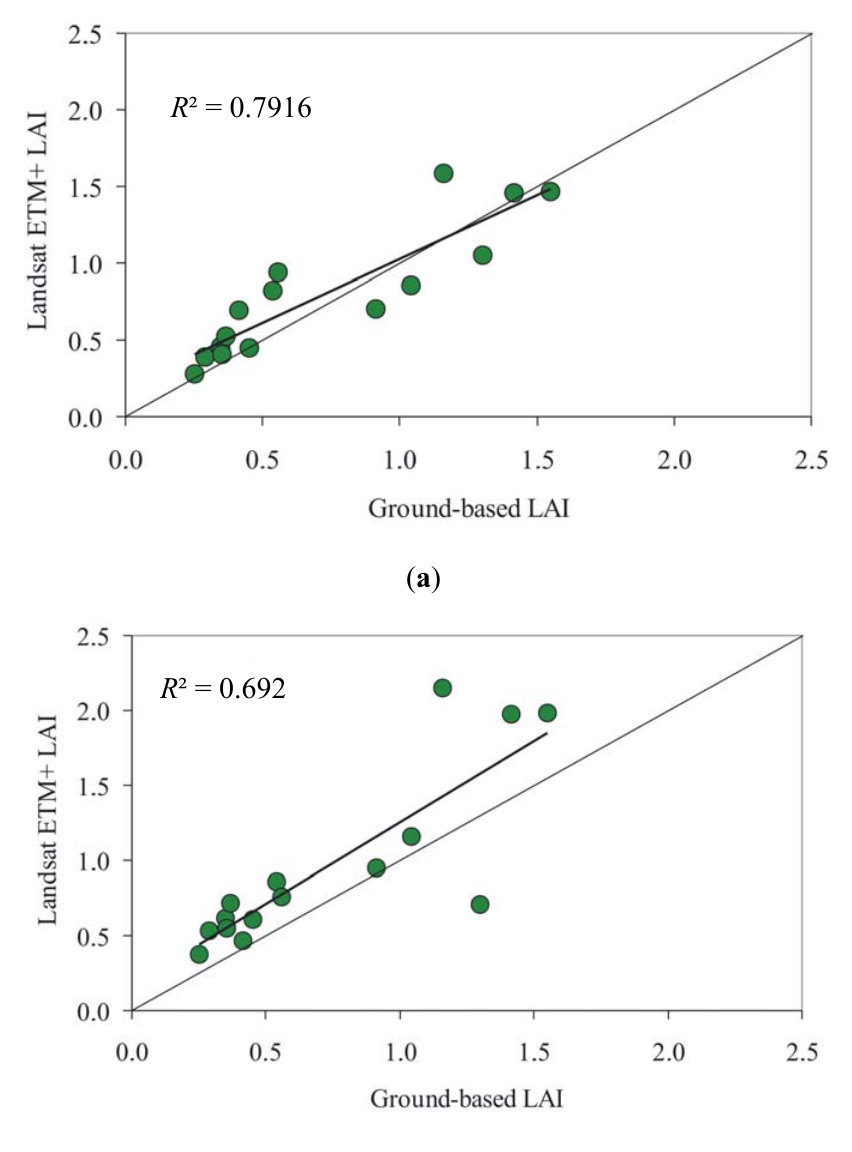
Figure 4. Validation of fine-resolution radiative transfer model (RTM)-based LAI products at the grassland test site in Shetsky region. ( a ) LAI retrievals from the fine-resolution RTM algorithm versus ground measured LAI for 2008. ( b ) LAI retrievals from the fine- resolution RTM algorithm versus ground measured LAI for 2004. ( c ) LAI retrievals from the fine-resolution RTM algorithm versus retrievals by the regression-based algorithm for 2008 in a pixel-by-pixel comparison ( n =